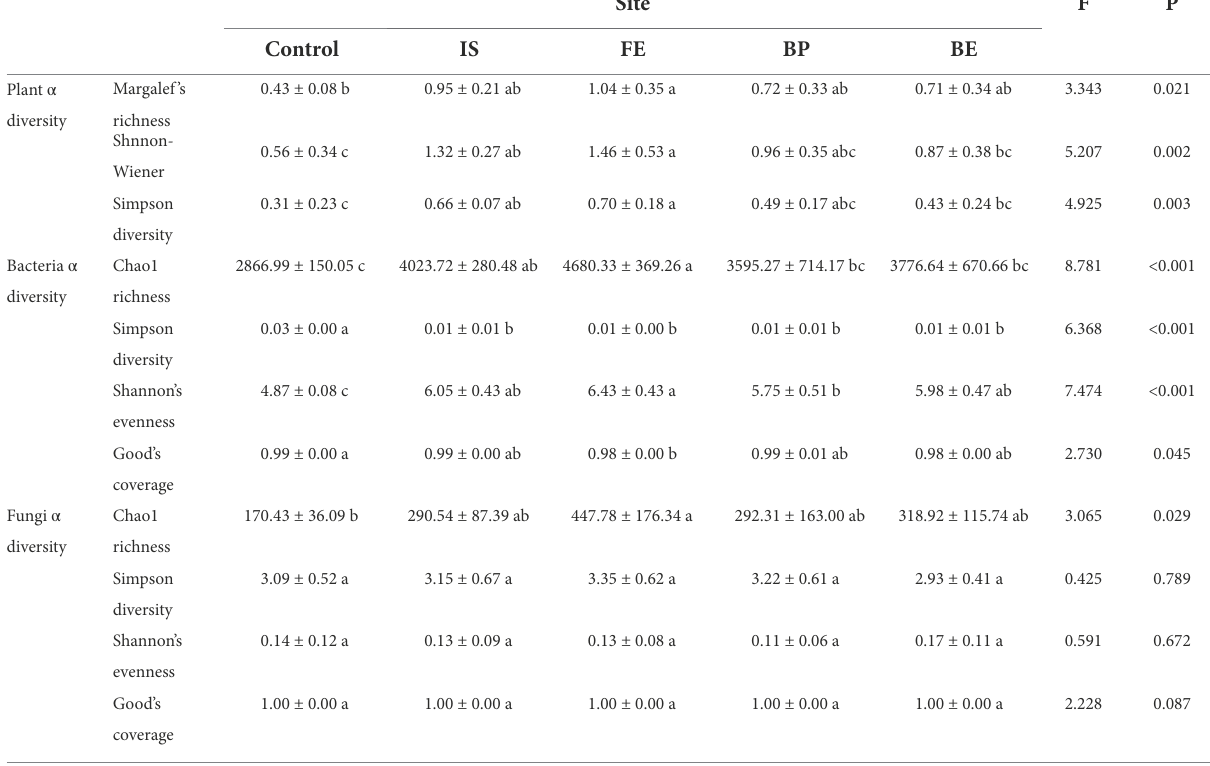
TABLE 1 One-way ANOVA analysis of the effects of PV panels on plant species, soil bacterial, and fungal diversity (FE: front edge of each panel, BP: beneath the center of each panel; BE: back edge of each panel; IS: the uncovered interspace adjacent to each panel; Control: the undisturbed grassland around the PV panels).